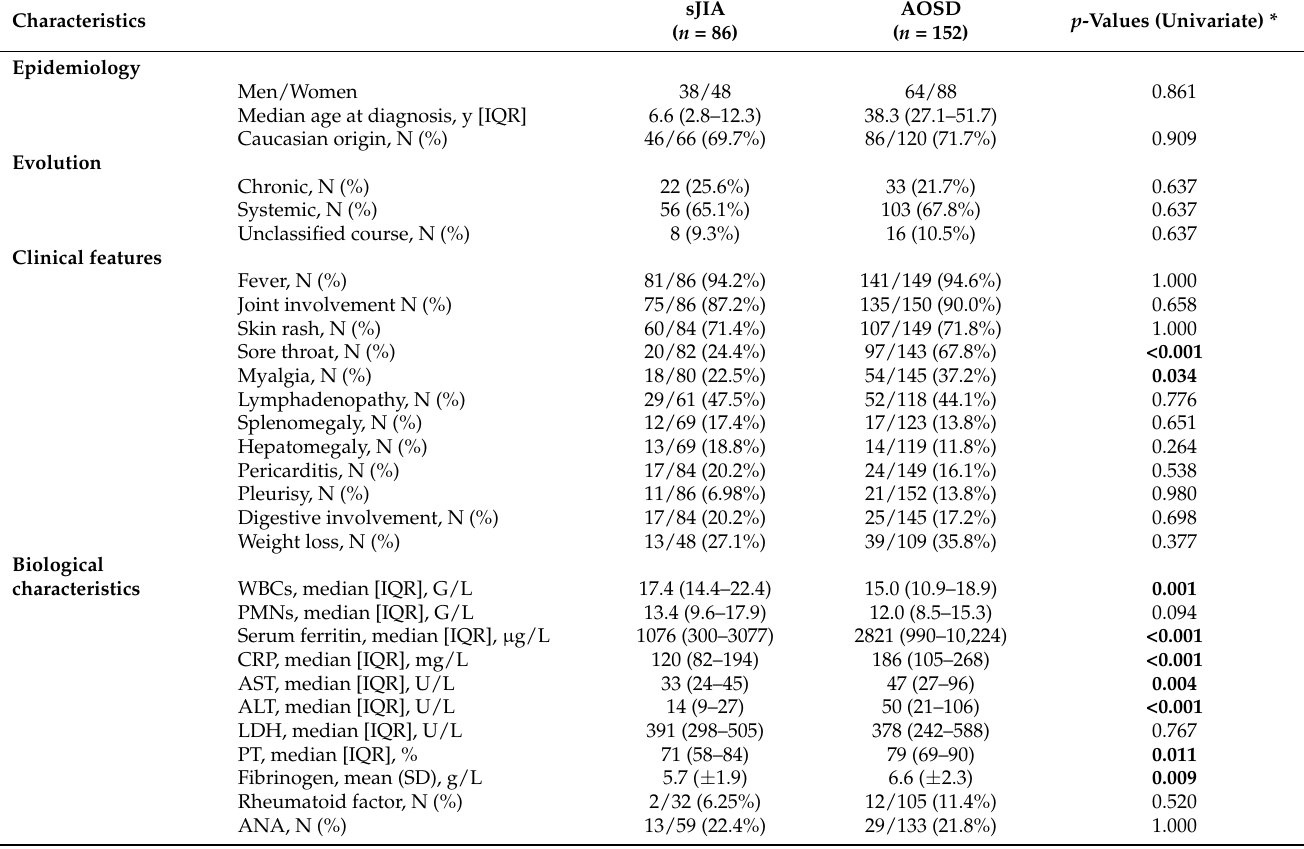
Table 3. Epidemiological, clinical and laboratory features of sJIA and AOSD